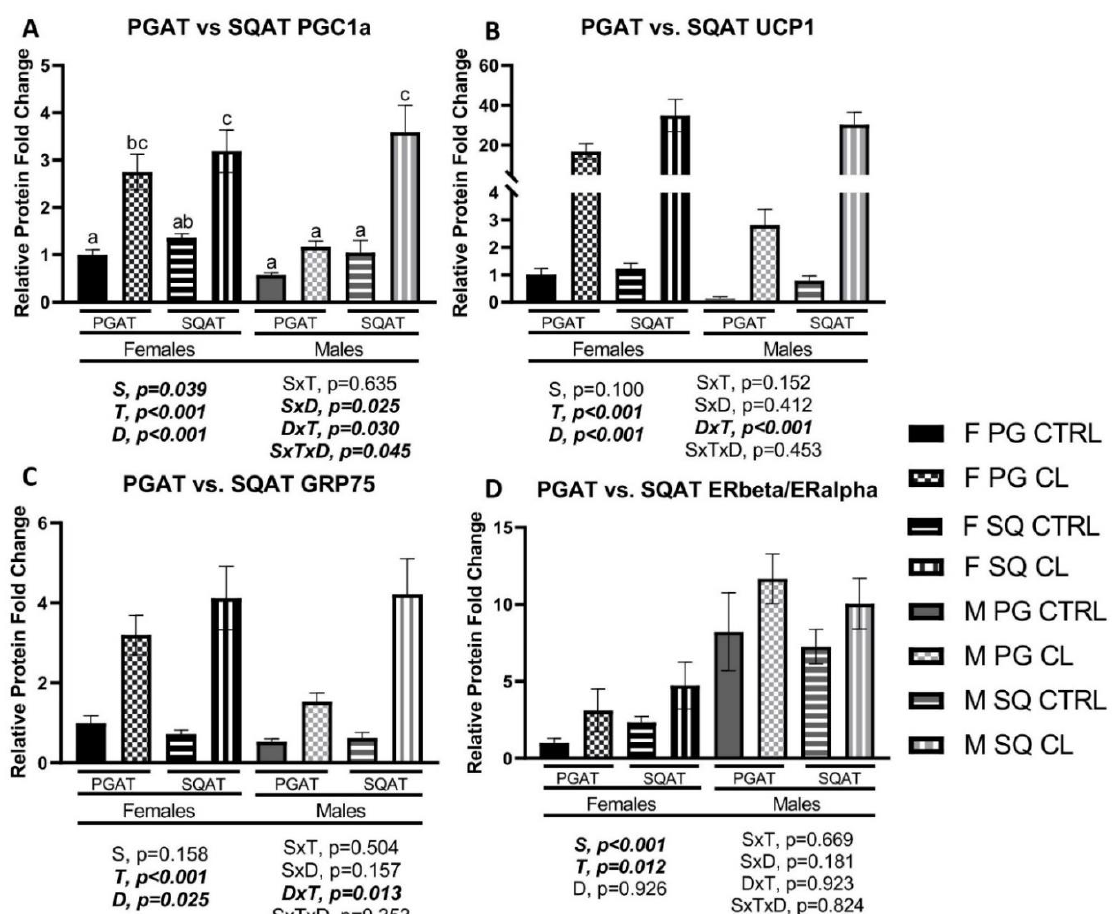
Figure 11. Male (M) and female (F) C57BL/6J mice, all on HFD, treated for 2 weeks with daily CL injections (1 μg/g body weight) or CTRL (saline). At sacrifice, two WAT depots (perigonadal (PGAT) and subcutaneous (SQAT)) were collected, and protein expression was assessed via Western blotting. ( A ) PPAR-gamma coactivator 1 alpha (PGC1a); ( B ) Uncoupling protein 1 (UCP1); ( C ) Glucose related protein 75 (GRP75); ( D ) Estrogen Receptor beta (ERb) to ER alpha (ERa) ratio. Representative Western blot images are provided in a Supplementary Figure. Blot intensity was expressed relative to beta actin. All data are presented as mean ± SEM, relative to the F PGAT CTRL. N = 7–9/group. Main effects of sex (S), CL treatment (T), and depot (D), as well as sex by treatment (S × T), sex by depot (SxD), depot by treatment (D × T), and sex by treatment by depot (S × T × D) interactions were determined by 2 × 2 × 2 ANOVA. p -values < 0.05 were accepted as significant. Lower case letters distinguish statistically different groups, as determined by Tukey’s post-hoc